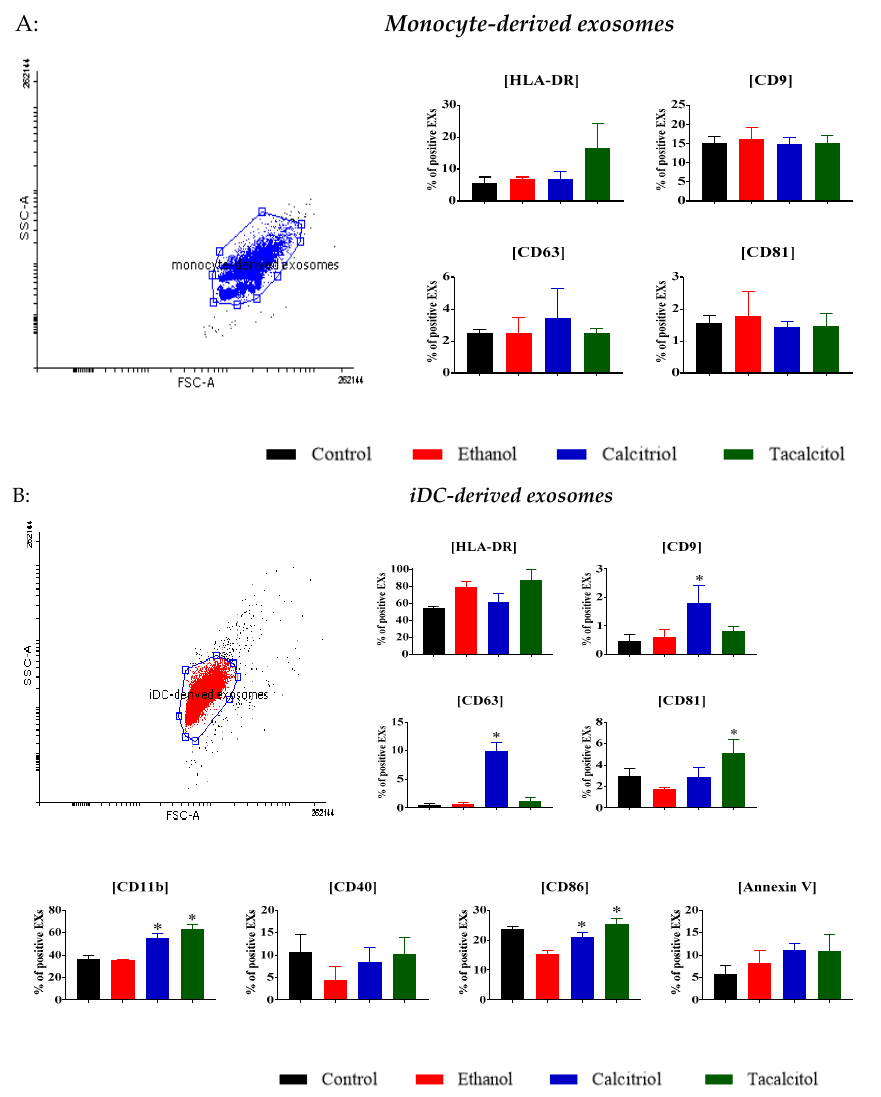
Figure 5. Characteristics of monocyte-derived and myeloid iDC-derived EXs: ( A ) distribution of differentiation markers of mo-derived EXs by flow cytometry analysis. Mean values and standard deviation are presented. Statistical analysis: Sidak’s multiple comparisons test; significant differences as compared with ethanol (* p < 0.005) The graphs represent data from at least three separate experiments; ( B ) distribution of differentiation markers of myeloid iDC-derived EXs by flow cytometry analysis. Mean values and standard deviation are presented. Statistical analysis: Sidak’s multiple comparisons test; significant differences as compared with ethanol (* p < 0.005). The graphs represent data from at least three separate experiments.